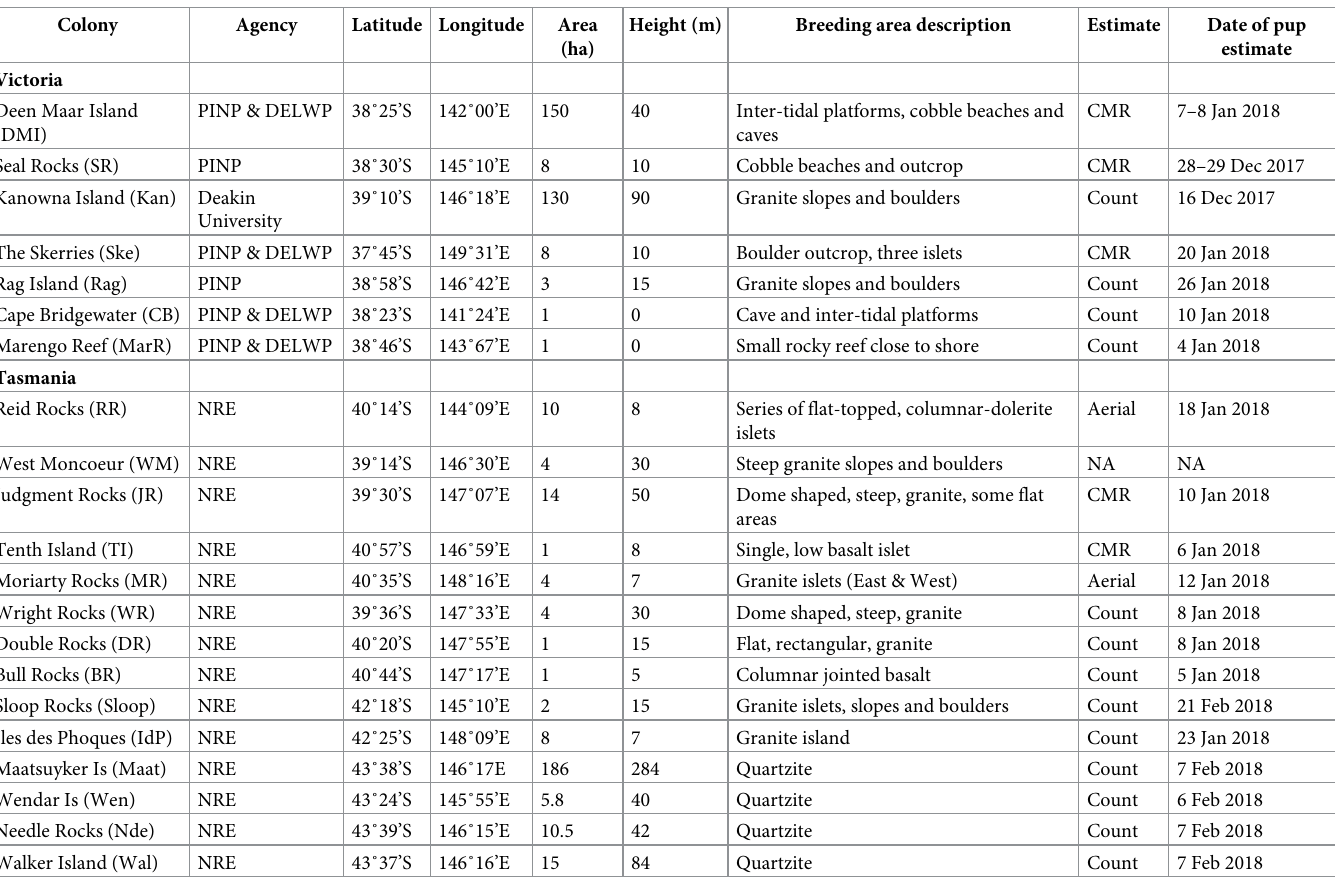
Table 1. Descriptions of colonies (n = 21) visited during the 2017 census of the Australian fur seal and dates of pup estimates from December 2017 to February 2018. Responsible agencies include Phillip Island Nature Parks (PINP), the Department of Land, Water and Planning Victoria (DELWP) and the Department of Nature Resources and Environment Tasmania